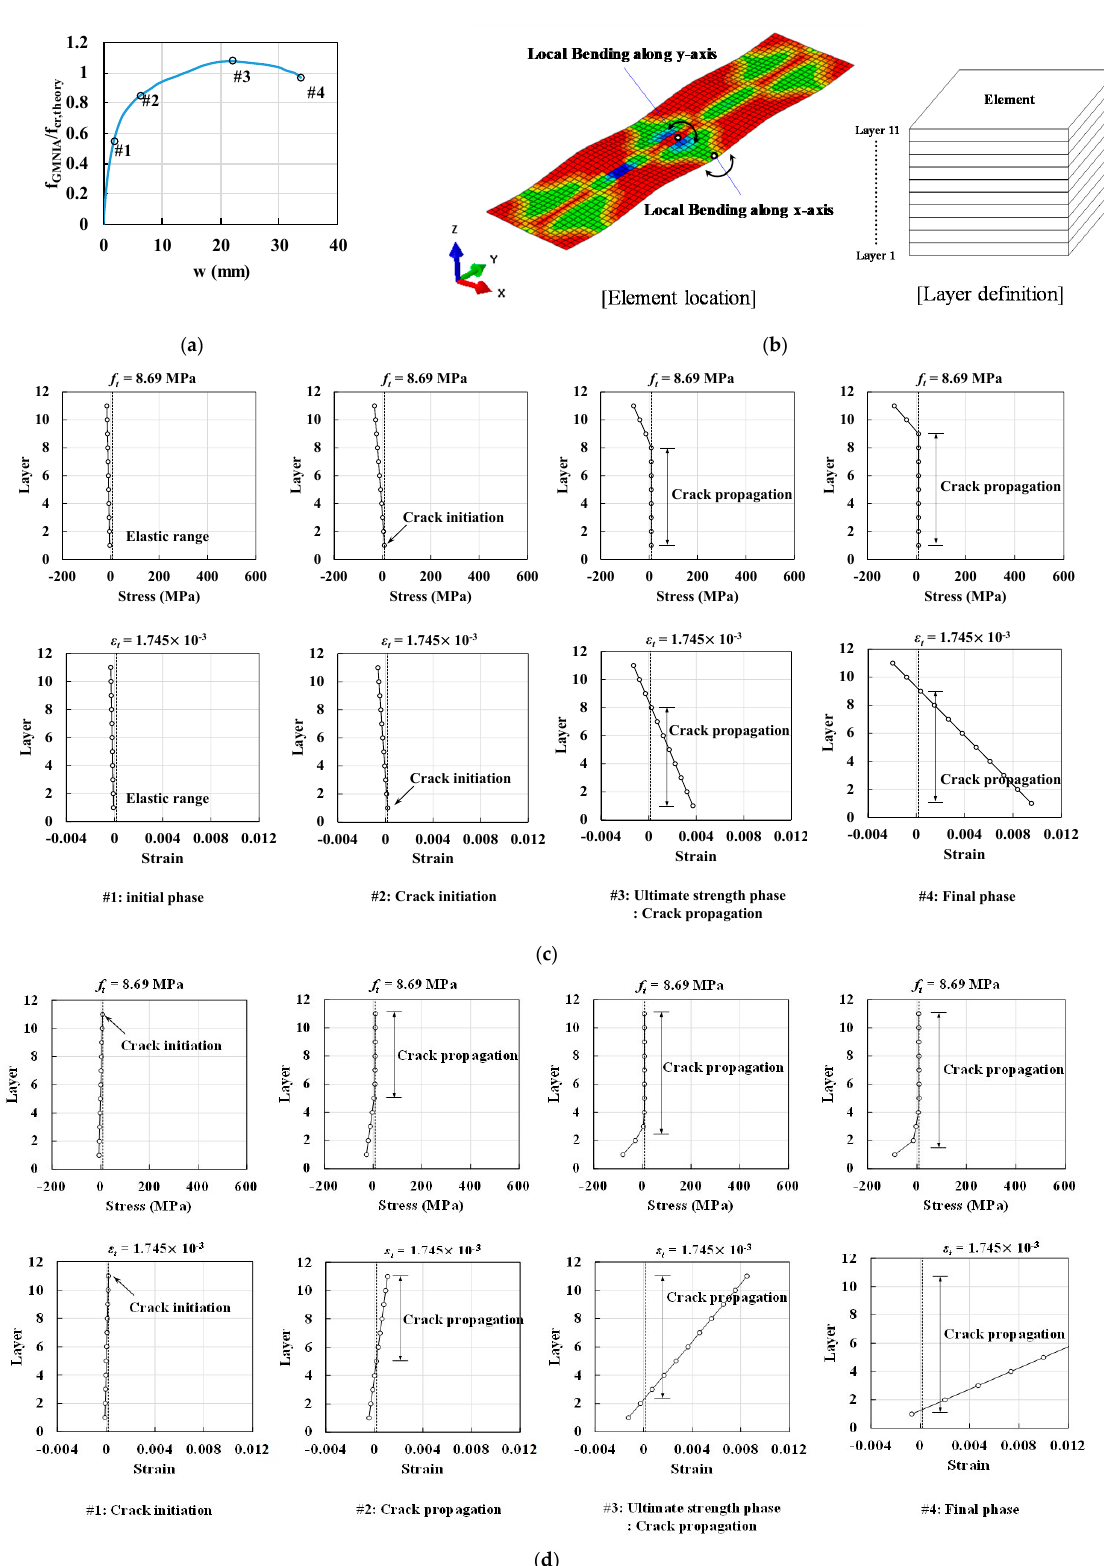
Figure 21. Comparisons of compressive stress and strain for UHPC flanges, modeled using the CDP material model, according to loading phases: ( a ) definition of loading sequence, ( b ) definition of local bending location and element layers, ( c ) normal stress distribution of local bending along the X -axis, and ( d ) normal stress distribution of local bending along the Y